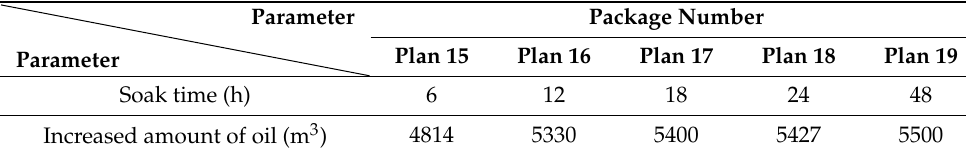
Table 10. Relation between soaking time and oil increase.